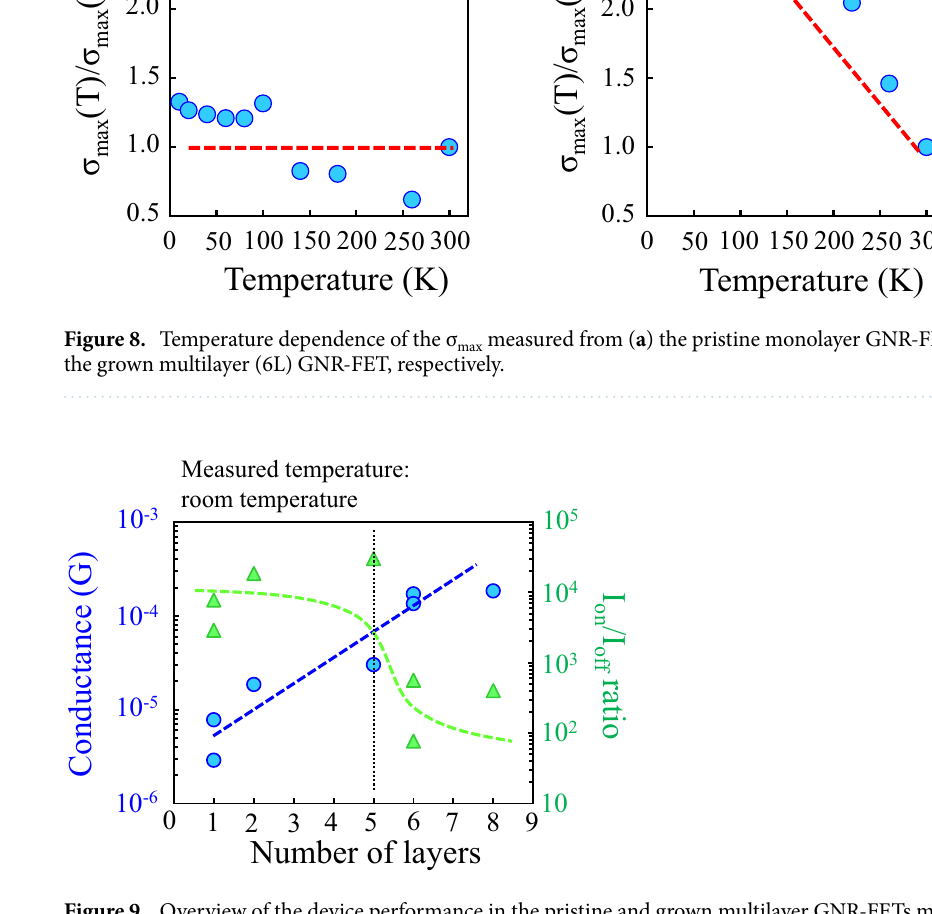
Figure 9. Overview of the device performance in the pristine and grown multilayer GNR-FETs measured at room